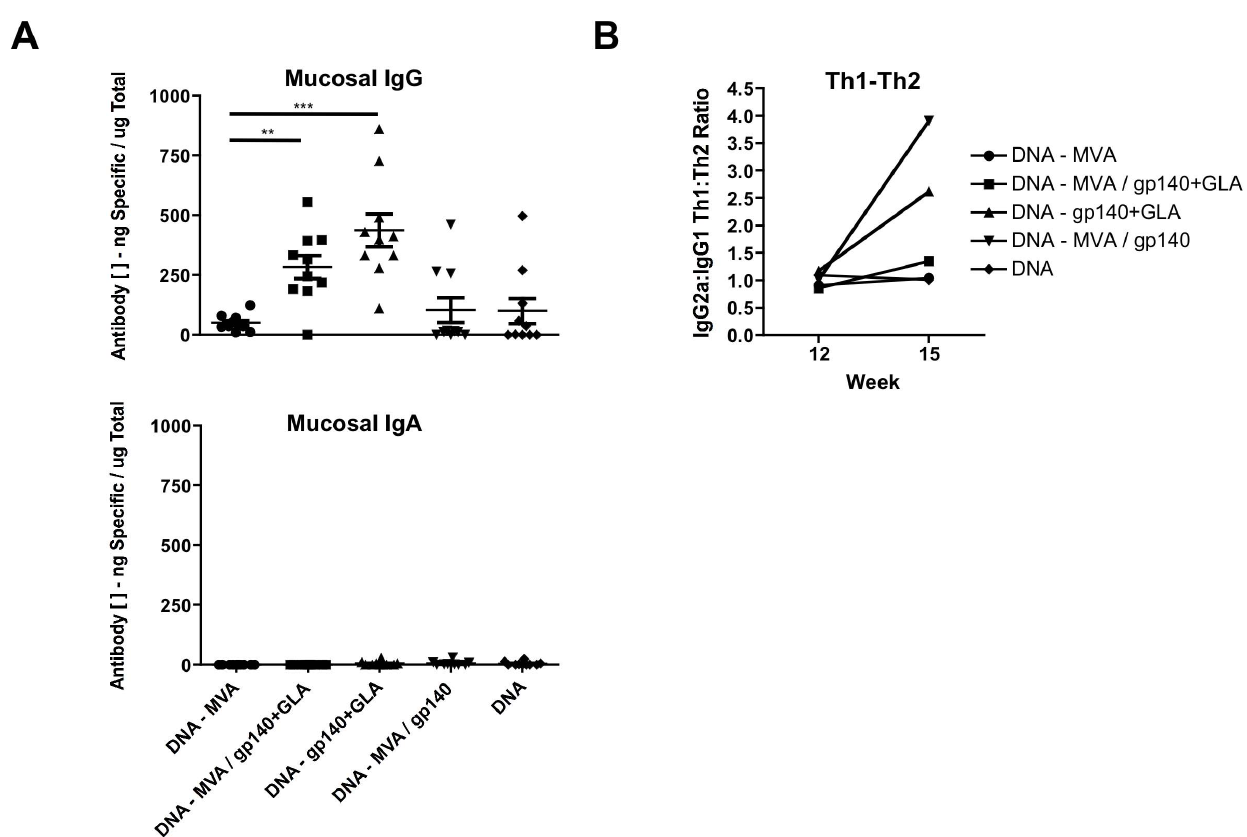
Figure 2. Gp140-Specific Mucosal IgG or IgA responses and serum IgG Th1/Th2 bias in DNA primed mice boosted with various combinations of MVA-C and/or CN54gp140 and GLA-AF. Female BALB/c mice ( n =10) inoculated with a total of 100 ug plasmid DNA (50 ug per leg; IM at week 0, 3 and 6) then boosted with variations of 10 7 PFU MVA-C and/or 10 m g recombinant protein with/without 20 m g GLA-AF adjuvant (IM inoculation at week 12) were assessed at week 15, three weeks after the first boost event. ( A) Mucosal vaginal wash samples contained moderate levels of vaccine antigen-specific IgG but very low levels of specific IgA (*** p , 0.0001; ** p =0.0015). ( B ) The effect of the boost inoculation upon the Th1:Th2 bias was assessed with the ratio of the IgG2a:IgG1 immunoglobulin isotype. Antigen-specific IgG, IgG1, IgG2a or IgA antibody was assessed by an immunoglobulin ELISA with a murine purified IgG, IgG1, IgG2a or IgA standard curve. Antigen-specific Ig concentrations are shown in m g/ml ( + / 2 SEM). Statistical comparisons were performed using a Mann-Whitney test.